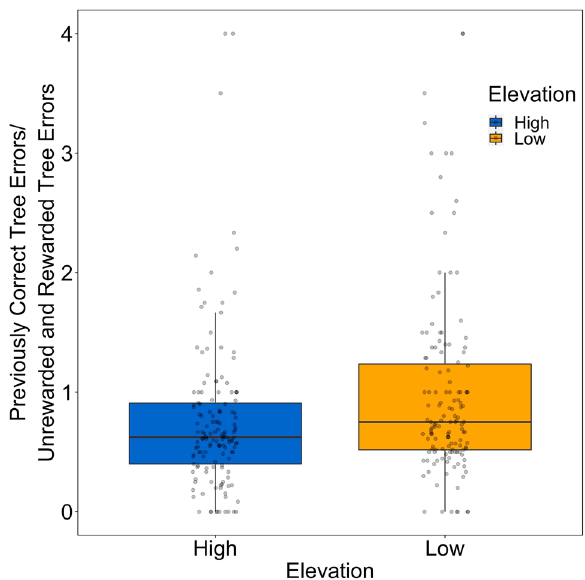
Figure 3. Boxplot of the untransformed previously correct tree errors/unrewarded and rewarded tree errors for high (blue) and low (orange) elevation birds. Raw number of errors are plotted in